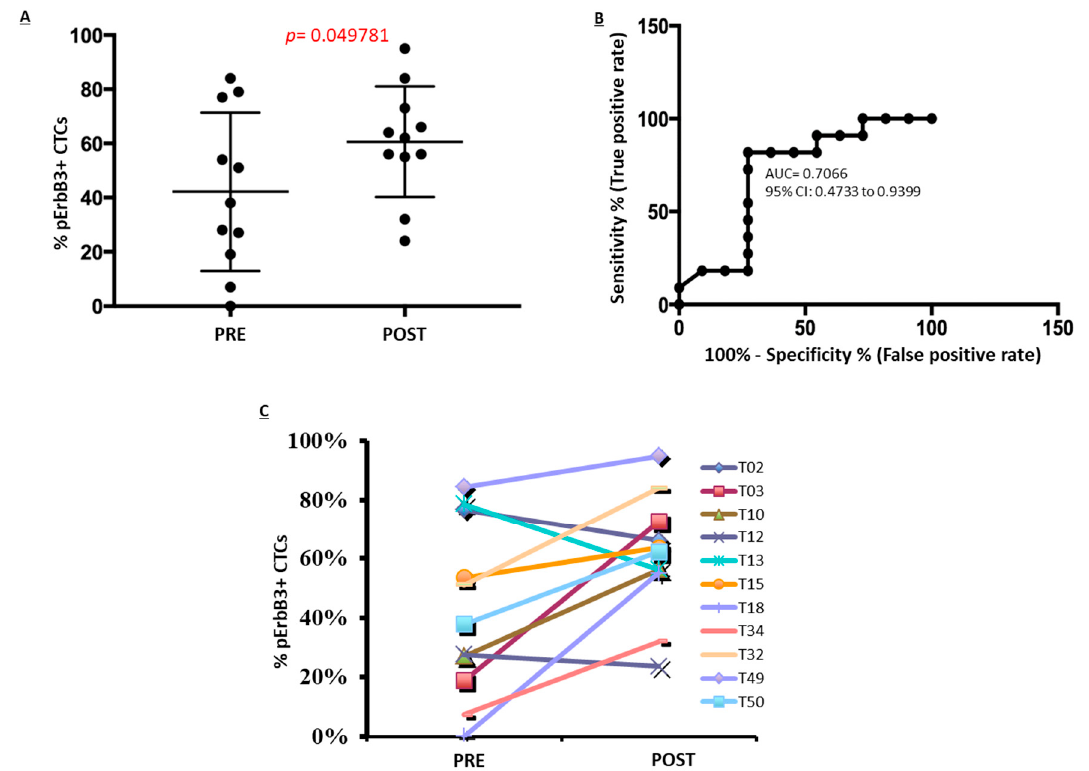
Figure 6. Statistical analysis. ( A ) Box-plot graph was obtained by GraphPad Prism software. Results show that the percentage of phospho-ErbB3 results to be activated greater in CTC’s melanoma patients upon treatment with MAPKi ( p < 0.05). p value was calculated using the t -test whose significance is expressed as p < 0.05. ( B ) The second panel depicts the individual patients’ analysis to evaluate ErbB3 receptor activation before and after short term MAPK inhibitor treatment. ( C ) Receiver operating characteristic (ROC) curves estimating the predictive value of ErbB3 activation as early marker upon treatment with MAPK inhibitors.